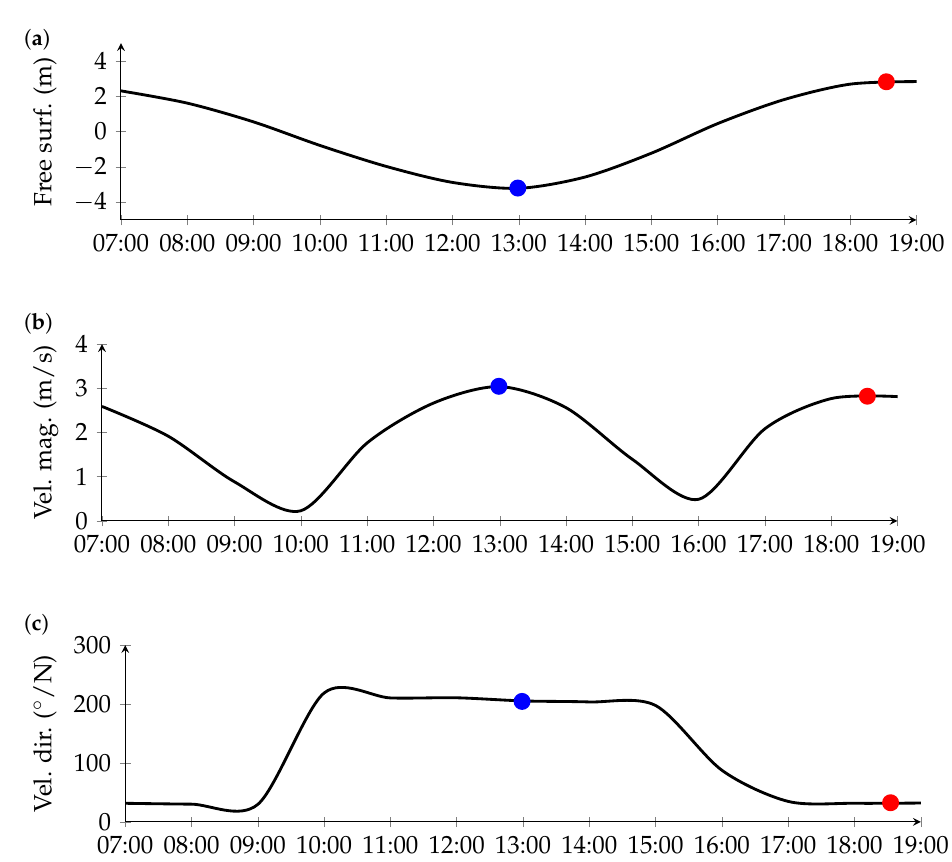
Figure 8. Time-series of ( a ) free surface elevation (with respect to the mean sea level), ( b ) depth- averaged velocity magnitude and ( c ) depth-averaged velocity direction (nautical convention) ex- tracted from the Telemac3D model (simulation without turbines) in the centre of the tidal farm (49.705 ◦ N; 2.103 ◦ W) during a mean spring tide on 9 August 2014. The peak ebb and flood are represented by blue and red circles,